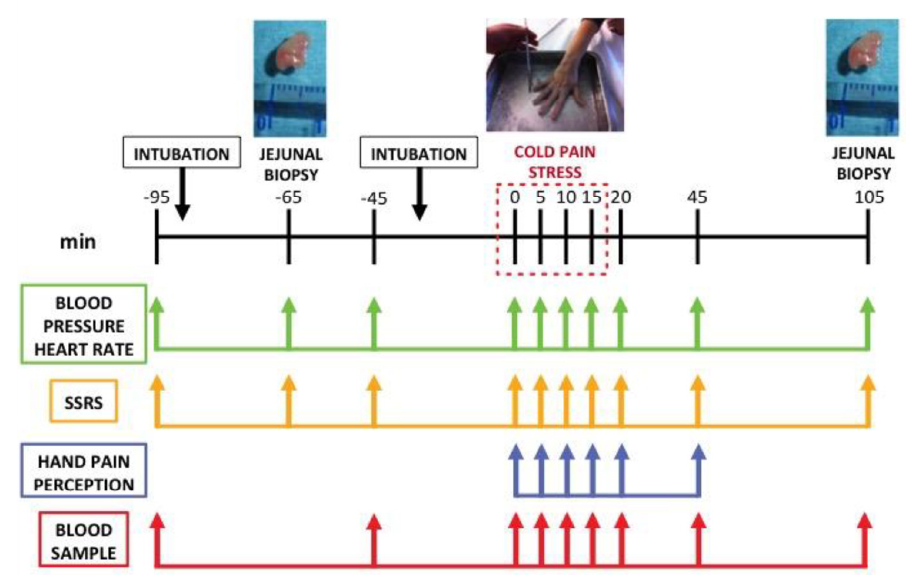
Figure 1. Experimental design and procedures. SSRS: subjective stress rating scale; Min: minutes. Baseline expression levels compared with the reference gene ( PPIA ) are expressed as median with first and third quartiles (Q1–Q3) and the differences by sex were parametric and analyzed with an unpaired t-test. Fold change expressions after and before stress corrected by the reference gene ( PPIA ) are expressed as median with first and third quartiles (Q1–Q3). Fold change effects by stress were analyzed using one sample t -test (compared Whitney U test for ZO3 and tryptase ( TRYP ) (no parametric variables) or unpaired t -test for the rest of genes (parametric